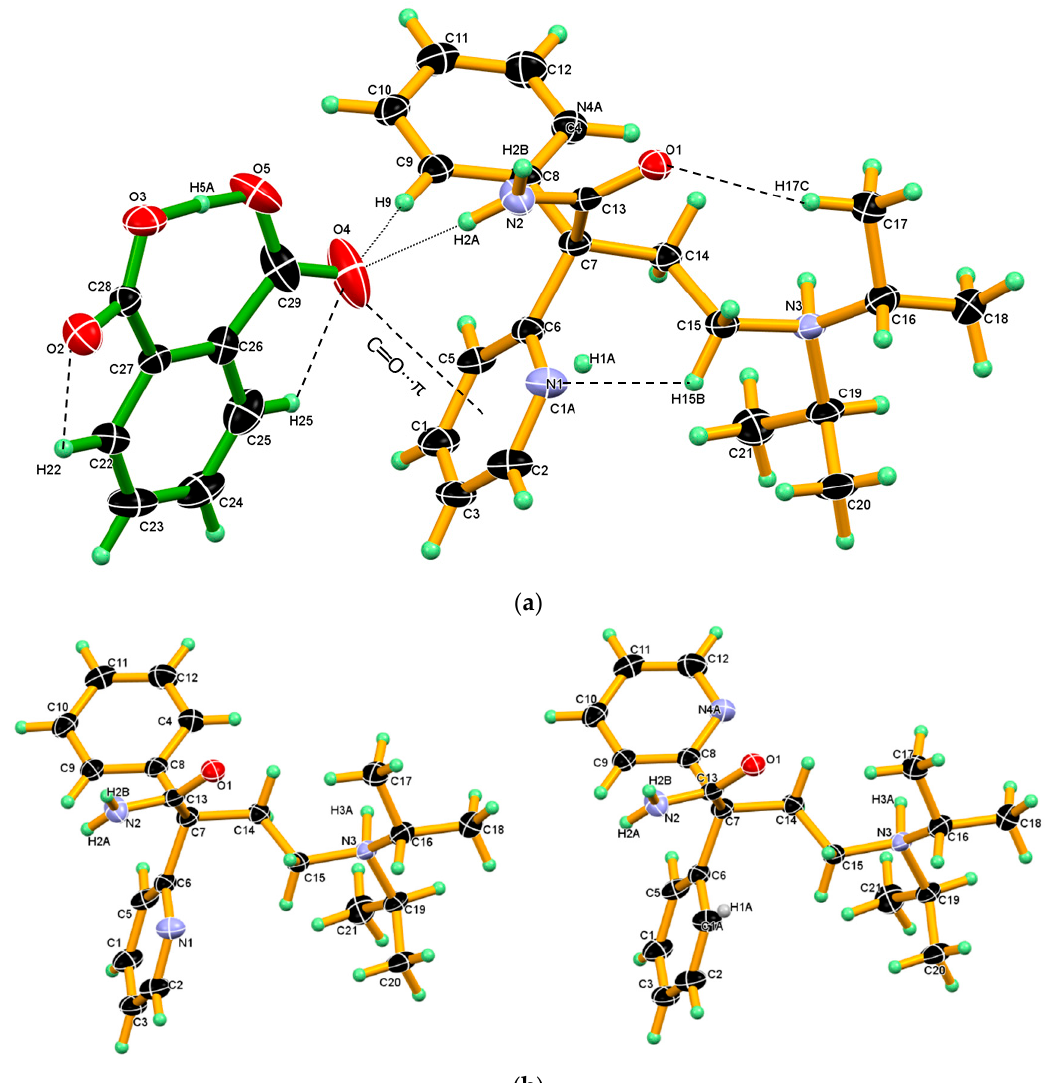
Figure 7. ( a ) ORTEP diagram of DPA_PA salt, showing the atom numbering scheme wherein C1, N4A and N1, and C1A share the same position. Thermal ellipsoid drawn at 50% probability level, and H-atoms are shown as small spheres with arbitrary radii. DPA_PA salts, displaying intramolecular hydrogen bonds O5-H5A ∙∙∙ O3, C17-H17C ∙∙∙ O1, C22-H22 ∙∙∙ O2, C25-H25 ∙∙∙ O4 C15-H15B ∙∙∙ N1 and intermolecular hydrogen bonds N2–H2A ∙∙∙ O4 and C9–H9 ∙∙∙ O4, C ═ O4 ∙∙∙π between the salt pair. ( b ) The disordered DPA molecule in salt crystal . R and S configuration molecules occupied the same site with 0.5 and 0.5 occupancy .